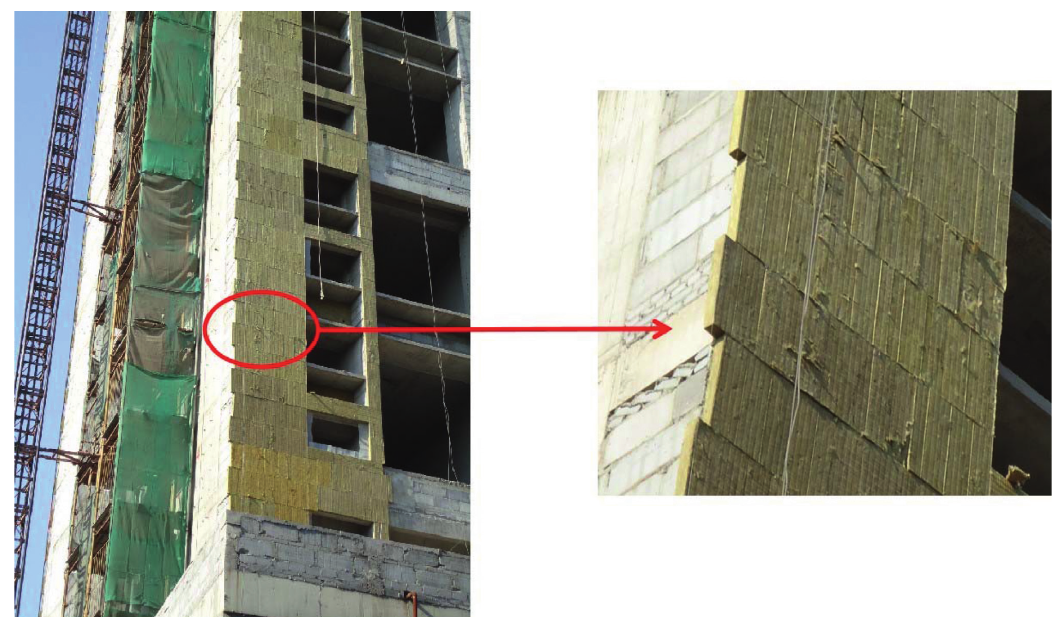
Figure 1: The installation process of